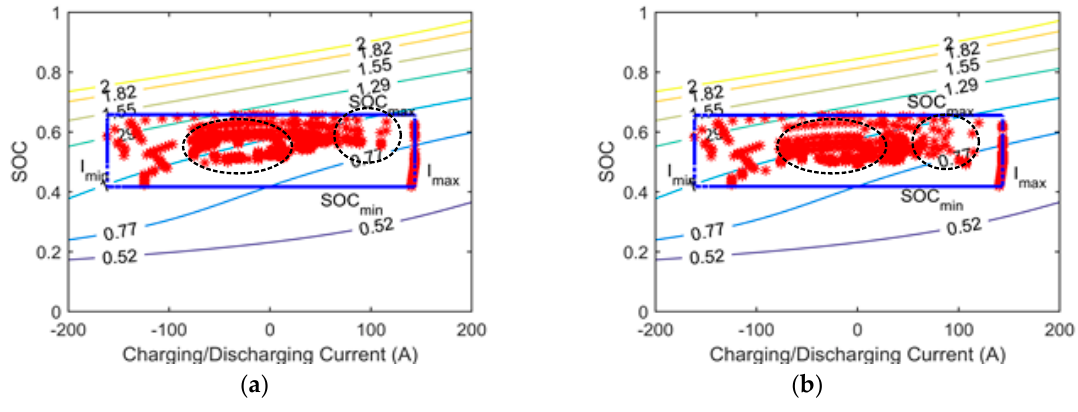
Figure 6. ( a ) ( I batt , SOC ) distribution of the anode-side SEI film growth map with α = 0; and ( b ) ( I batt , SOC ) distribution of the anode-side SEI film growth map with α = 0.3.